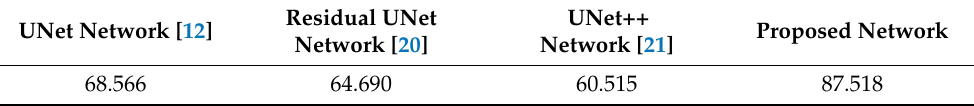
Table 10. Measurement of processing time of various segmentation networks (unit: ms).